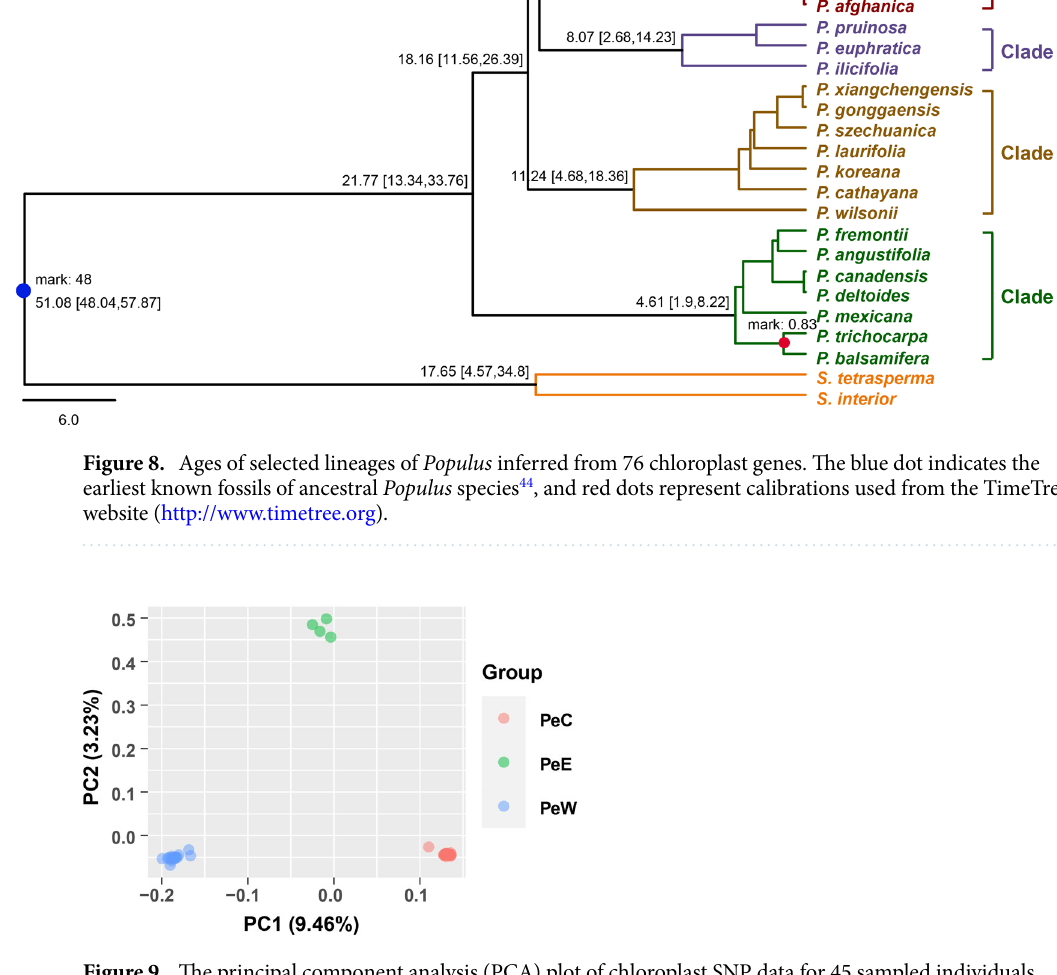
Figure 9. The principal component analysis (PCA) plot of chloroplast SNP data for 45 sampled individuals. Color coding reflects different geographic collection